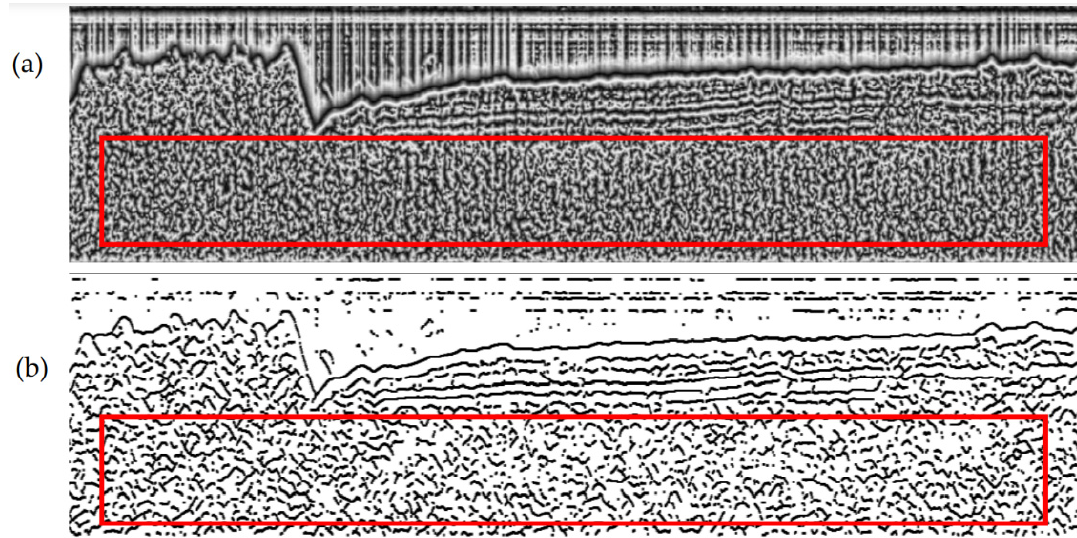
Figure 10. Local phase and the detailed horizons without diffusion filtering. ( a ) shows the local phase image without diffusion filtering. ( b ) shows the detailed horizons picked from ( a ). Red rectangles show the outliers .